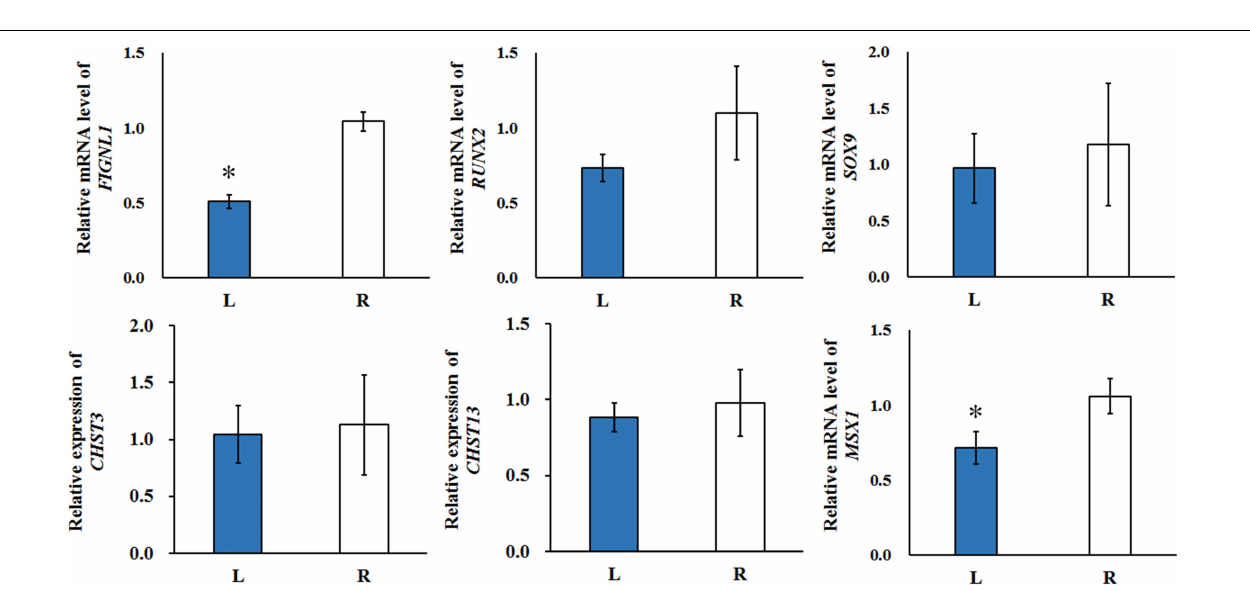
FIGURE 7 | The enriched GO term in biological process related with calcification (A) and top 20 enriched KEGG pathways (B) of CHH context differentially methylated genes (DMGs). Numbers in the red circles represent the gene number.